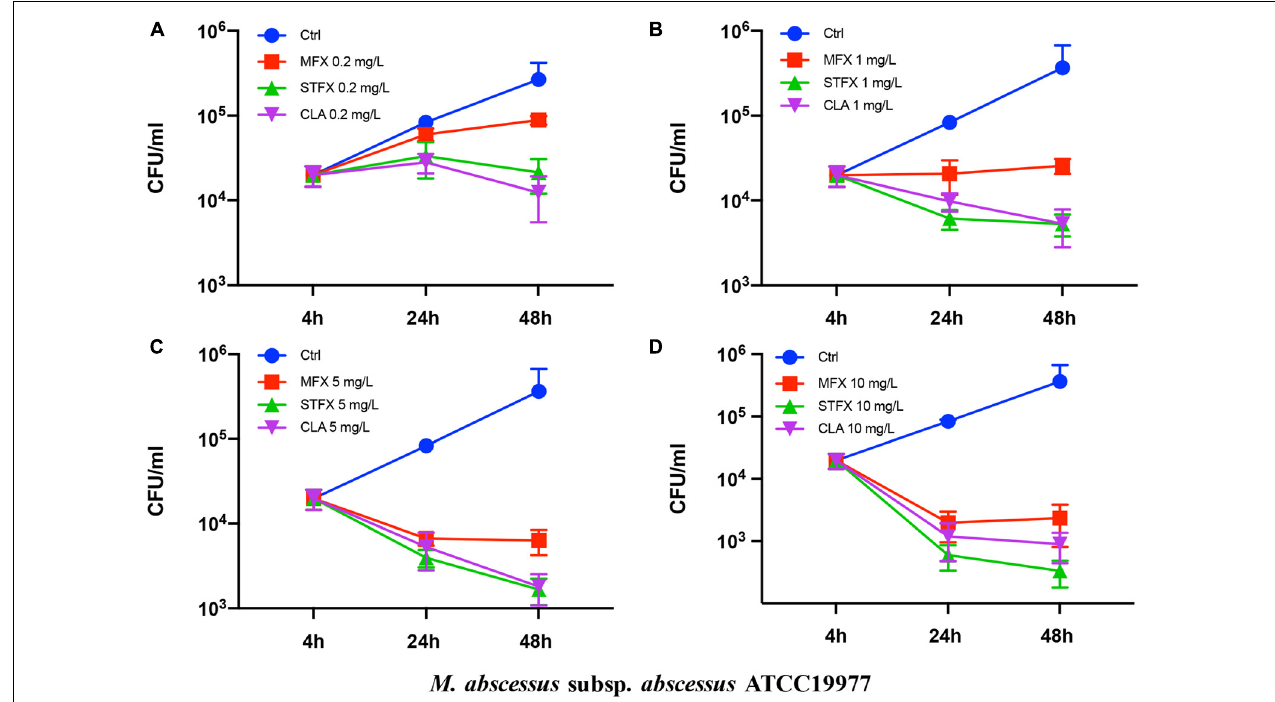
FIGURE 1 | Antimicrobial activities of sitafloxacin, moxifloxacin and clarithromycin against M. abscessus subsp. abscessus ATCC19977 growing intracellularly. Antibiotics at 0.2 (A) , 1 (B) , 5 (C) , and10 (D) mg/L final concentrations were added to cultures of M. abscessus -infected macrophages. CFUs were quantified after 4, 24, and 48 h incubation. Ctrl, control; STFX, sitafloxacin; MFX, moxifloxacin; CLA, clarithromycin.